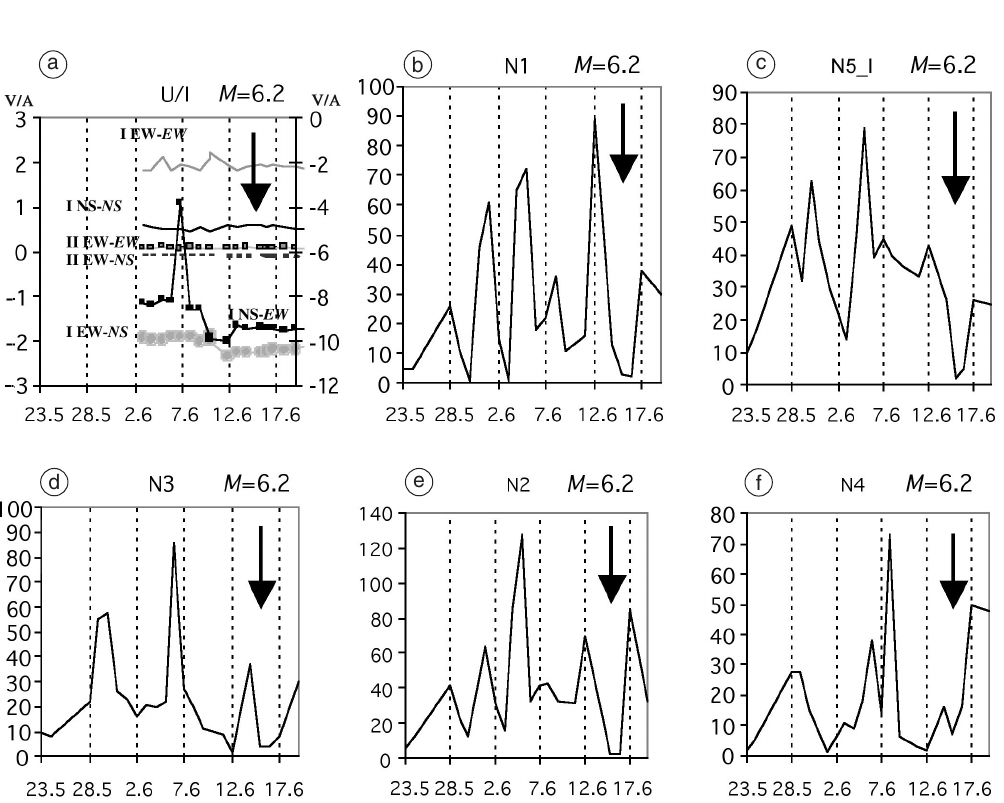
Fig. 6a-f. Variations of the average daily rock electroconductivity and numbers of ULF signals for the five clusters at the period from 23 May up to 19 June 1991. The Roman numbers designate the points of meas- urement. Here NS and EW specify the directions of measuring lines, whereas the italic NS and EW specify the directions of generating lines. The Arabic numbers specify the clusters. The arrow indicates the time of the